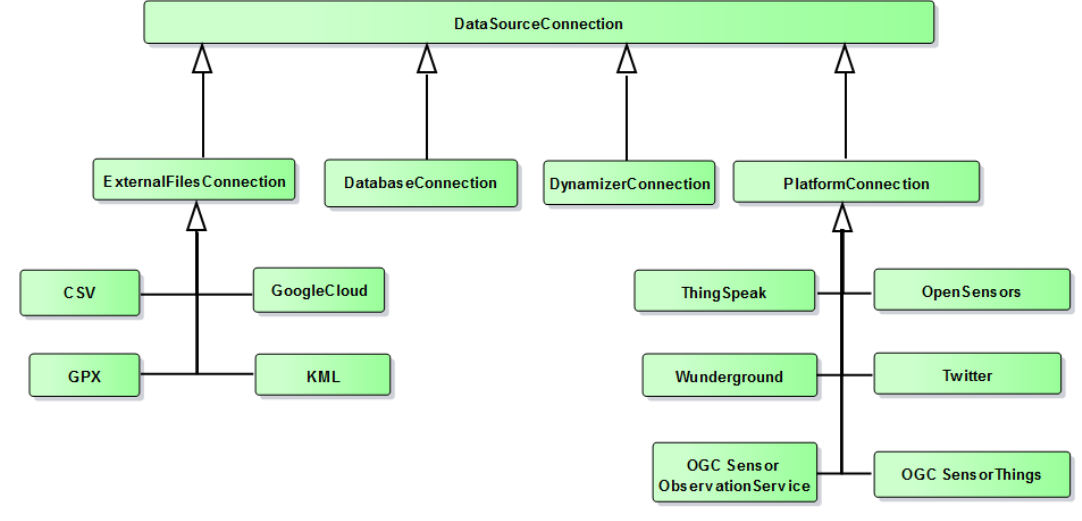
Figure 5. Representation of types of data sources which can be used by the InterSensor